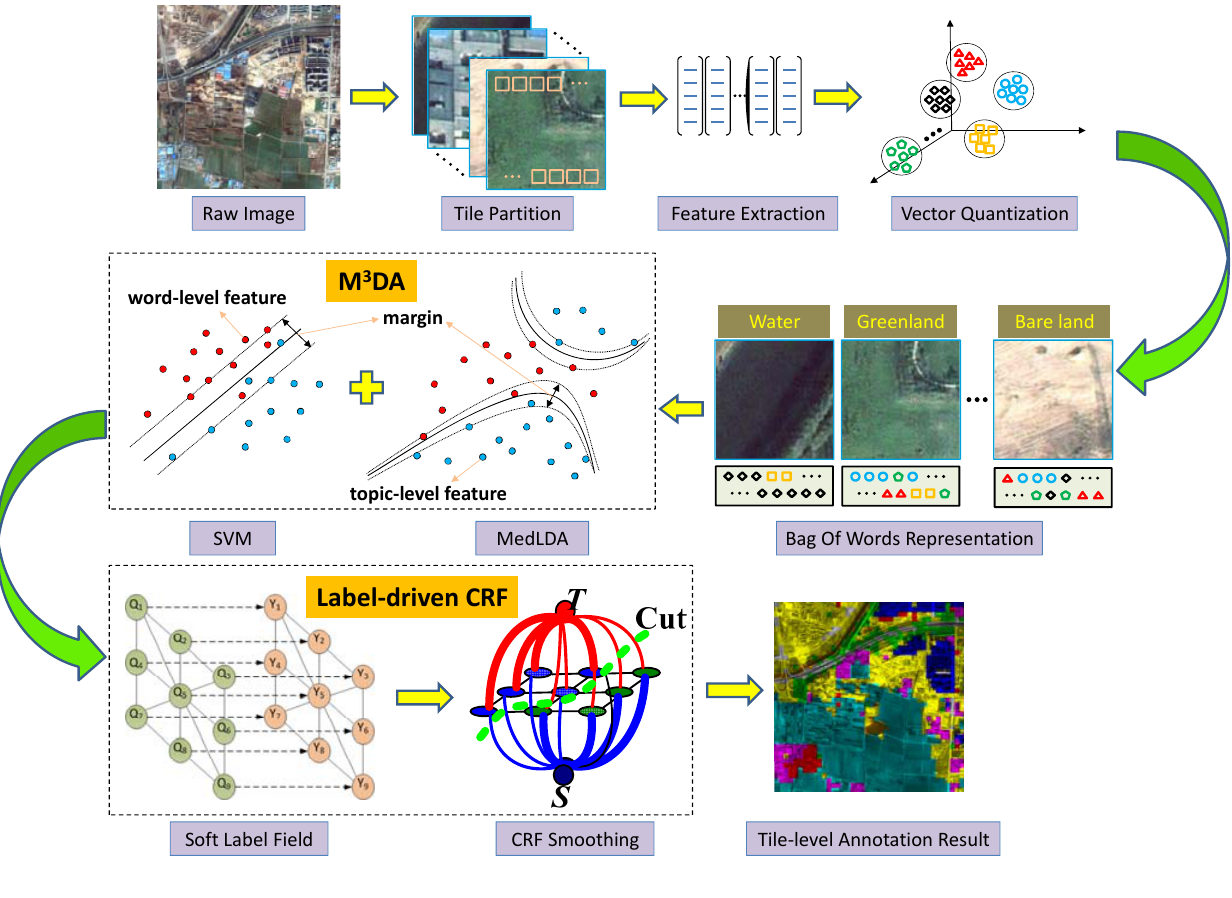
Figure 4. Flowchart of the proposed M 3 DA-RF based tile-level annotation algorithm.